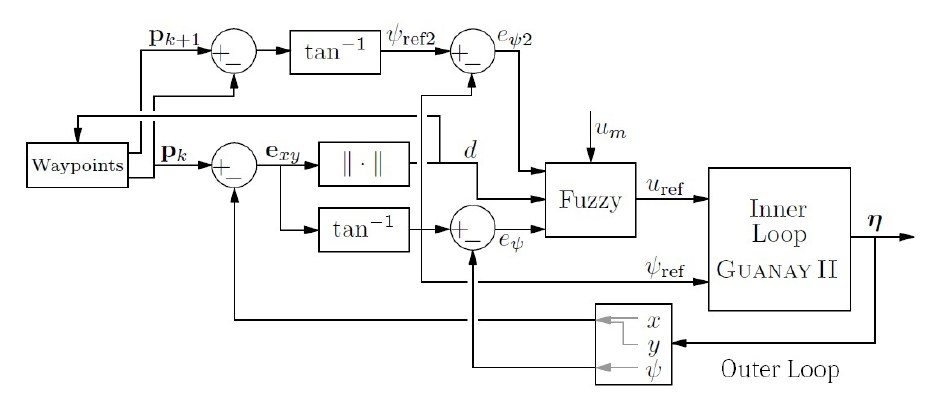
Figure 20. Outer loop: pure pursuit using a fuzzy controller.